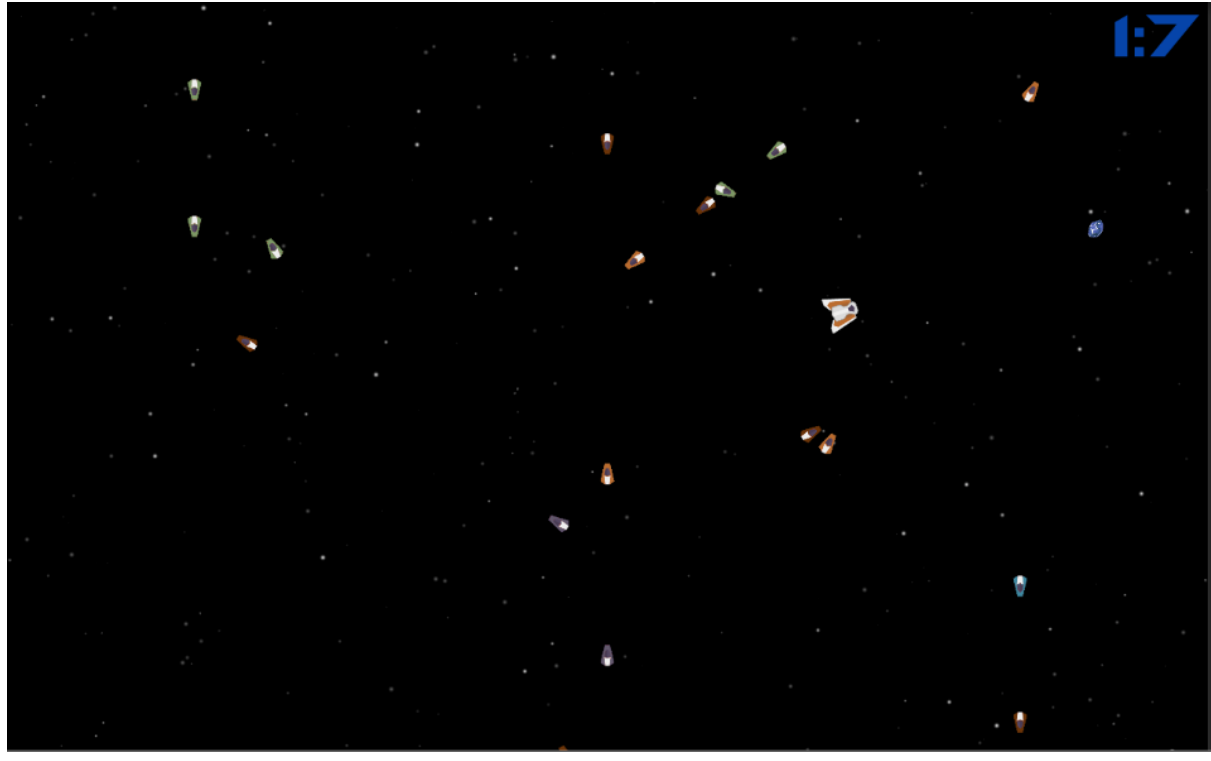
Figure 4. Screenshot of the Space game from Prototype